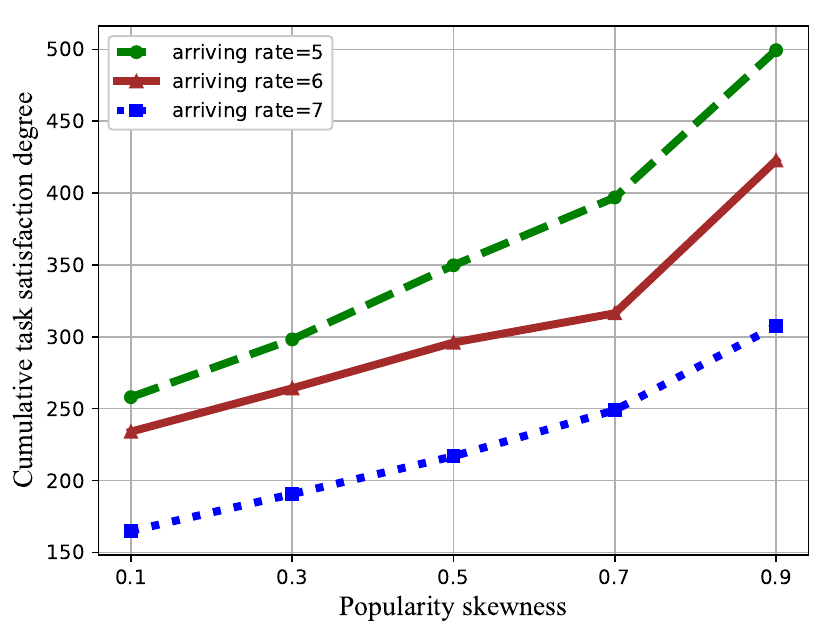
Figure 7. Cumulative task satisfaction degree versus the popularity